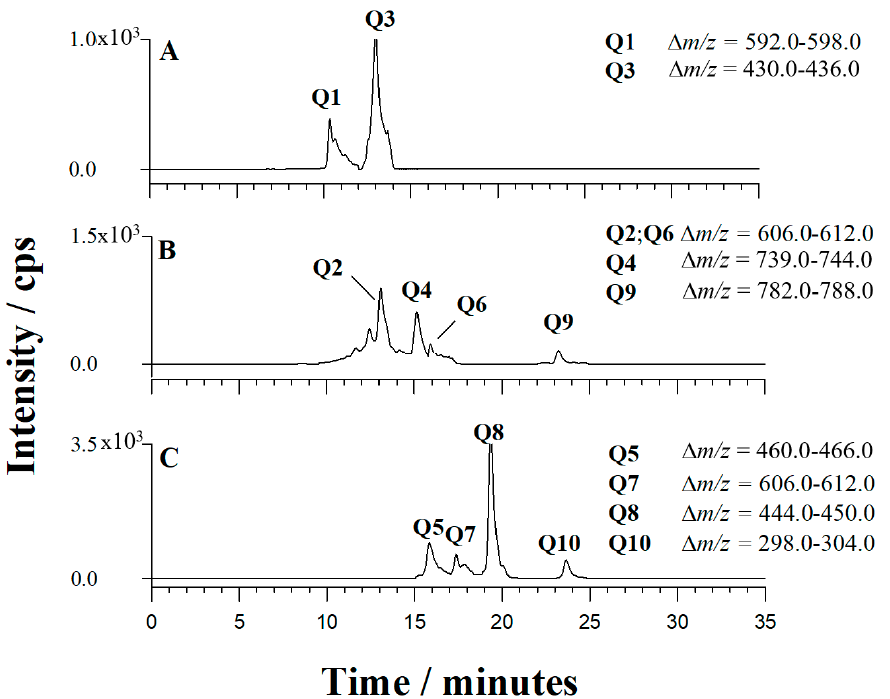
Figure 1. Extracted ion current (XIC) chromatograms by LC-ESI(-)-LTQ-MS of quercetin derivatives occurring in methanolic extract of peppers belonging to a modified genotype of the Habanero white and identified through the use of commercially available standards ( A ), tandem mass spectra interpretation ( B ), Log P-RT correlation ( C ). A window of ± 3.0 m / z unit centred around the selected [M − H] − ion was chosen. Peak numbers correspond to ( Q1 ) quercetin-6- C - hexoside-8- C -pentoside/apioside, ( Q2 ) quercetin-4 ′ -rhamnoside-7-hexoside, ( Q3 ) quercetin-7- O - pentoside/apioside, ( Q4 ) quercetin-3- O -pentosyl/apiosyl-rhamnosyl-hexoside, ( Q5 ) quercetin-7- O - glucoside, ( Q6 ) quercetin-3- O -rhamnoside-7- O -hexoside, ( Q7 ) quercetin-3- O -rutinose, ( Q8 ) quercetin-7- O -rhamnoside, ( Q9 ) quercetin rhamnoside-(feruloyl-hexoside) and ( Q10 ) quercetin.